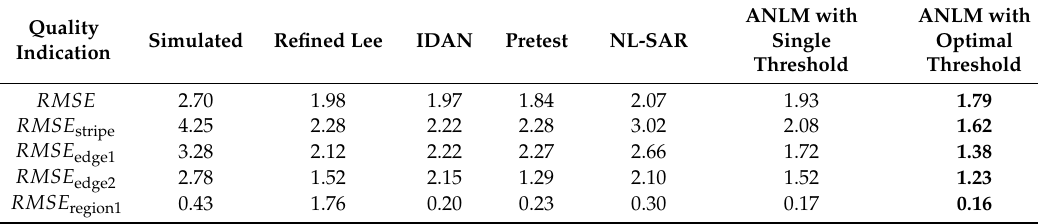
Table 1. The standard deviations between the filtered and real CM on different filtering methods. Quality